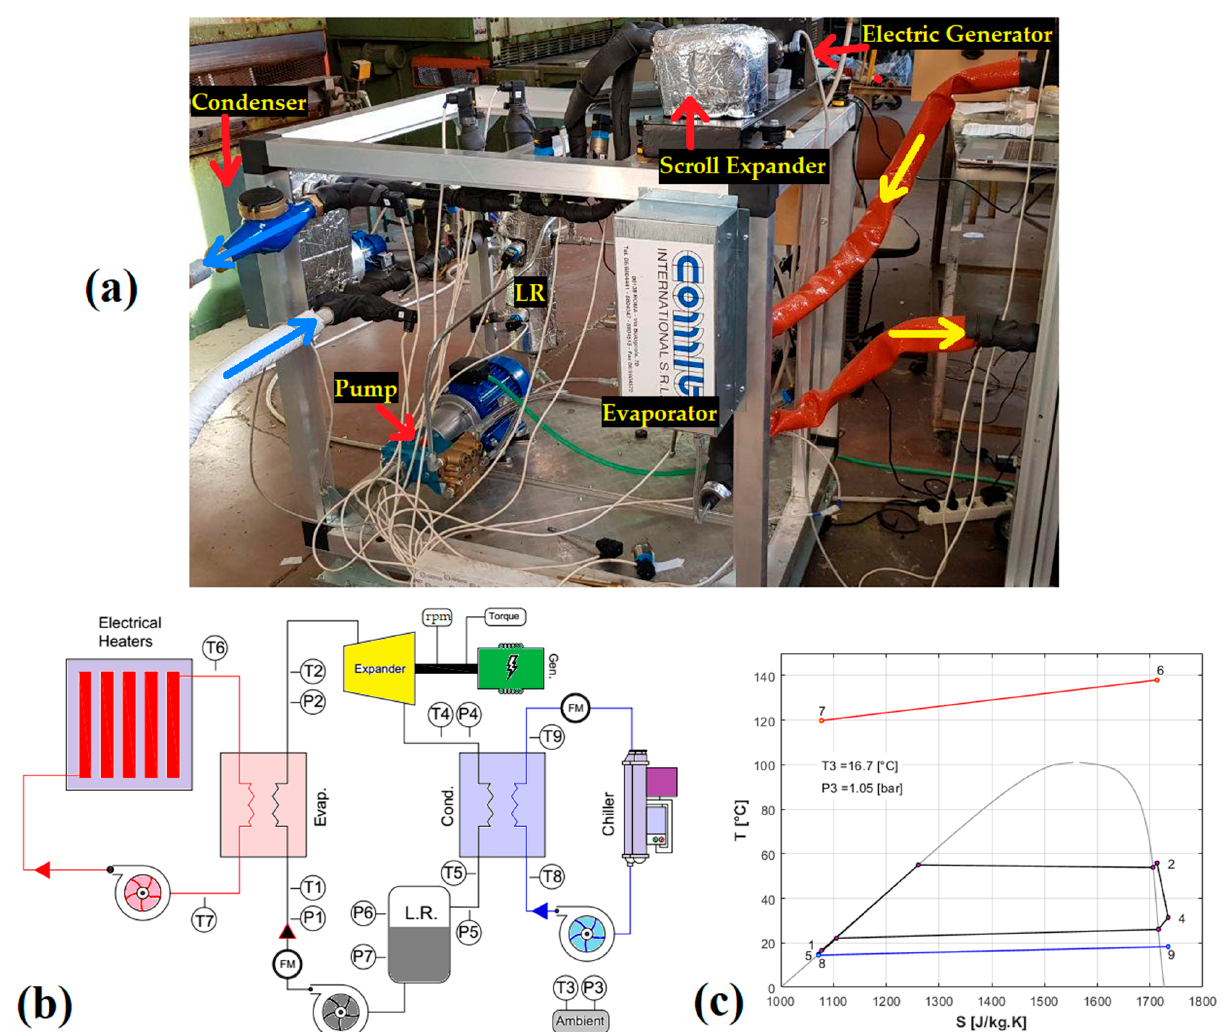
Figure 1. The photo of the organic Rankine cycle (ORC) test bench ( a ), the system schematic ( b ), and the temperature-entropy (T-S) diagram for a given operating condition during the tests ( c ).